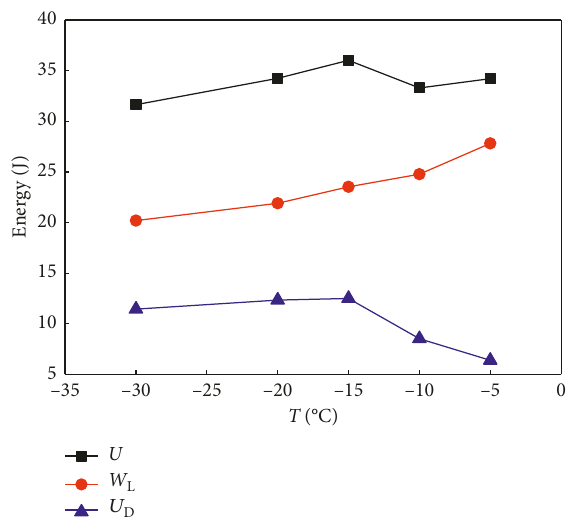
Figure 8: The relationship between each energy and freeze-thaw temperature in yellow